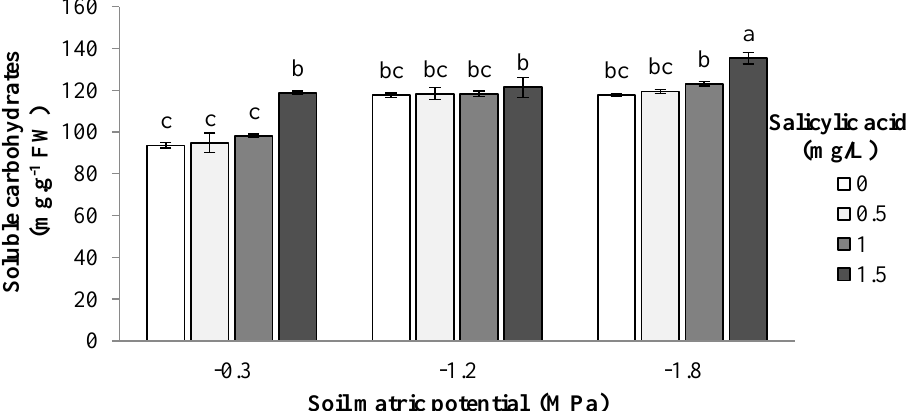
Figure 5. Interaction effects of controlled water stress and foliar application of SA on soluble carbohydrates of pumpkin.